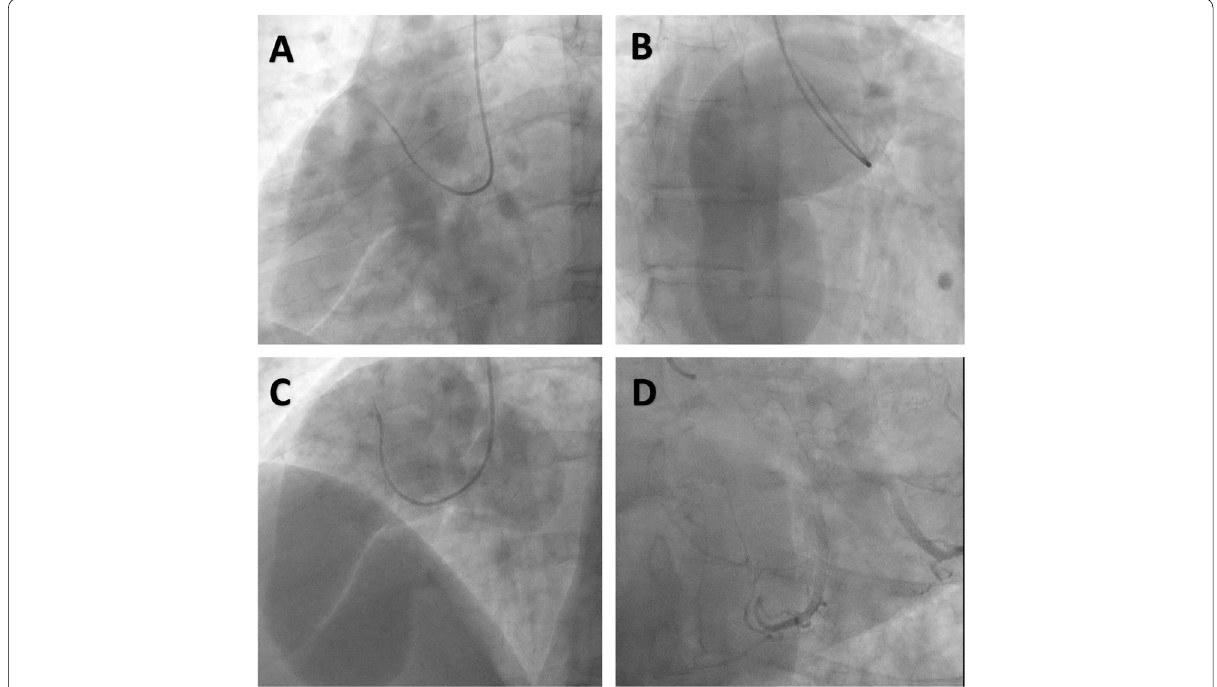
Fig. 2 A – C Coronary angiography showing the aneurysm with contrast filling of the right atrium in the absence of opacification of the distal right coronary artery (RAC). Catheterization showed slightly increased pressure of the pulmonary artery (42/20 mmHg), pulmonary capillary wedge